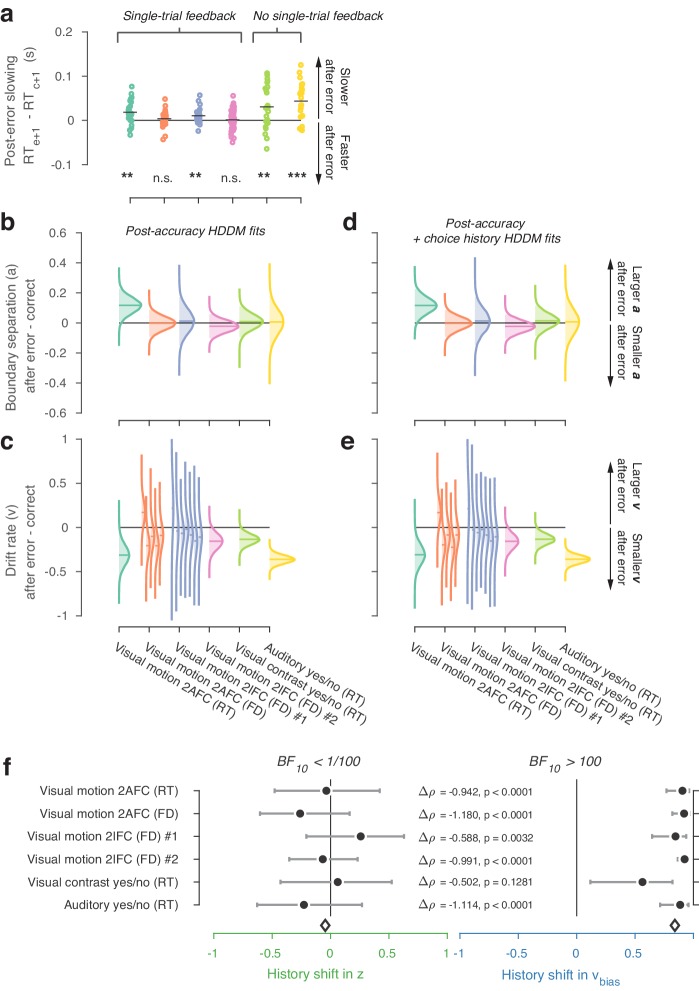
Repeaters vs. alternators.(a) Correlations between individual history shifts in starting point or drift bias and repetition probability, fit separately for groups of ‘repeaters’ (P(repeat)>0.5) and ‘alternators’ (P(repeat)<0.5). (b) Summary of correlations (as in Figure 4c) separately for repeaters and alternators. Error bars indicate the 95% confidence interval of the correlation coefficient. Δρ quantifies the degree to which the two DDM parameters are differentially able to predict individual choice repetition, p-values from Steiger’s test. The black diamond indicates the mean correlation coefficient across datasets. In the Visual contrast yes/no RT dataset there were no alternators, so this dataset was excluded from the overview.